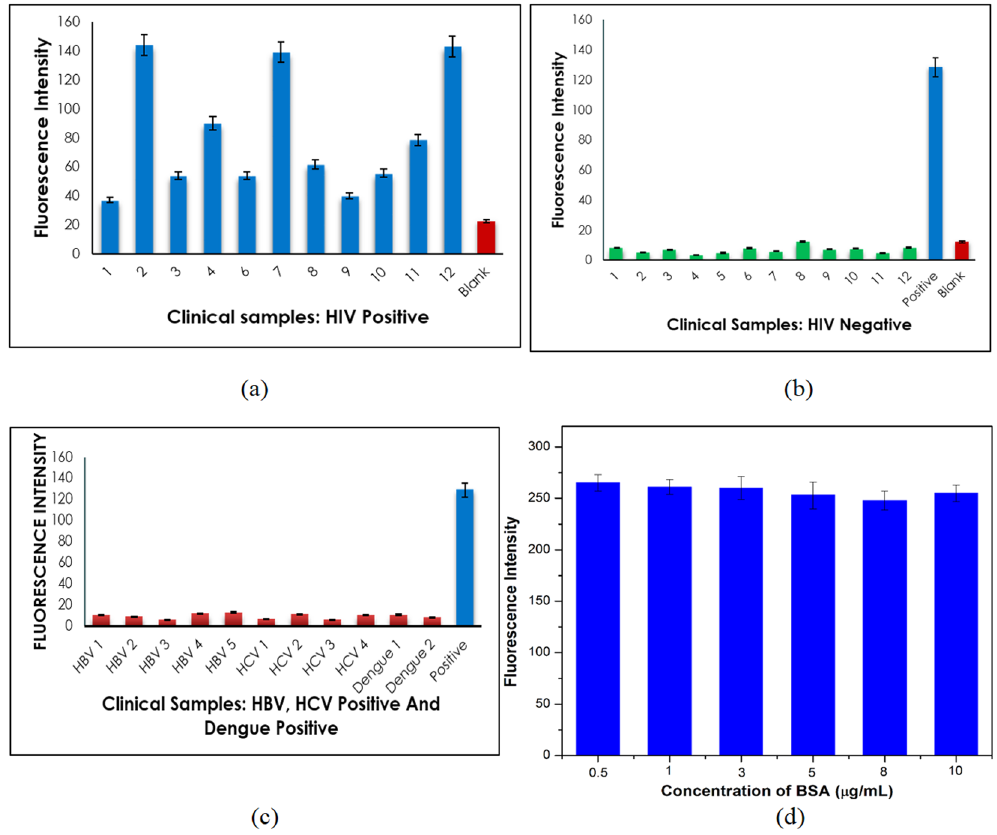
Figure 6. ( a ) SNIA applied to HIV positive samples and compared with the results from negative sample and blank. The blue and red bars denote the positive sample and blank. ( b ) SNIA applied to HIV negative samples and compared with the results from blank and HIV positive sample. The green, blue and red bars denote the negative, positive sample and blank respectively. ( c ) SNIA on HBV positive/HIV negative, HCV positive/HIV negative and dengue samples which are compared with the result from a HIV positive sample and a blank. The red bars denote the HBV positive/HIV negative, HCV positive/HIV negative, dengue samples and blue bars denote the lowest measured positive samples, respectively. ( d ) Evaluation of the effect of presence of BSA as an interfering protein on